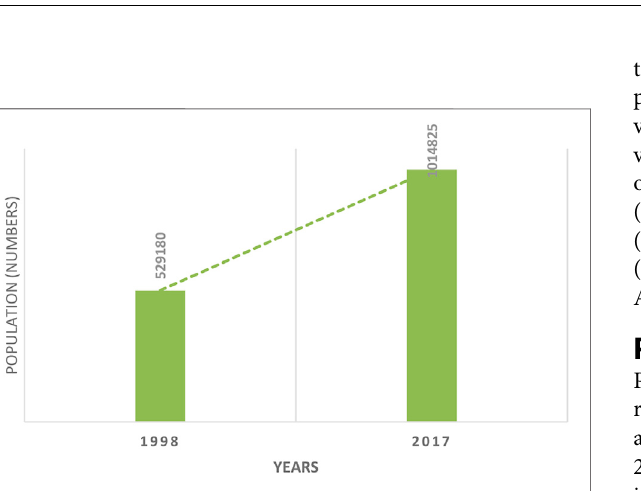
FIGURE 5 | Populace rate in Islamabad